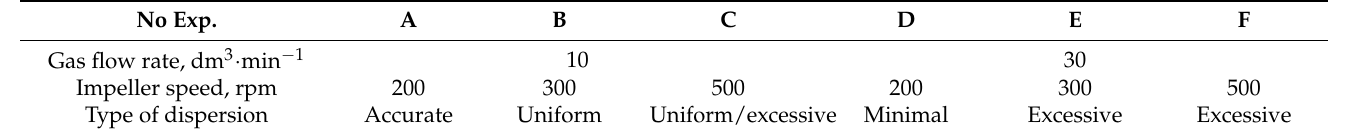
Table 8. Summary of visualization results (impeller RT3)—different types of gas bubble dispersion. No Exp. A B C